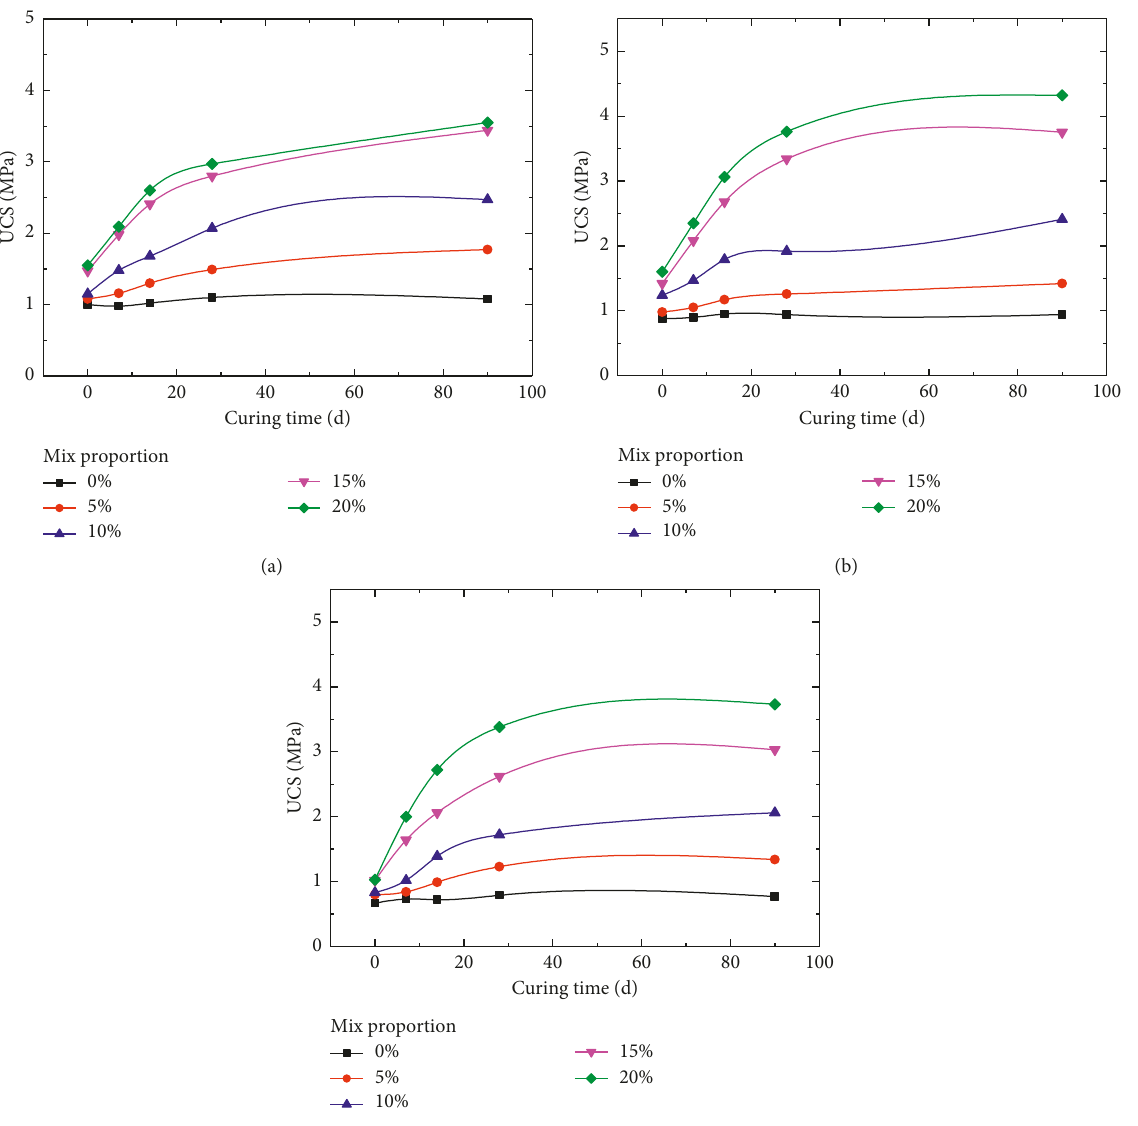
Figure 17: Unconfined compression strength of expansive soil stabilized by RHA-lime in different curing time. (a) w (b) w 1.2OMC, and (c) w (cid:30) (cid:30)